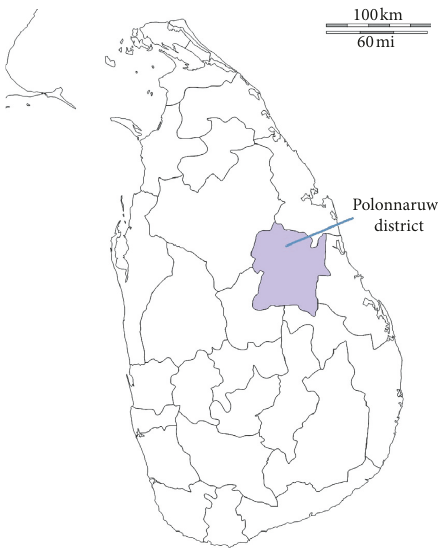
Figure 1: Location of Polonnaruwa